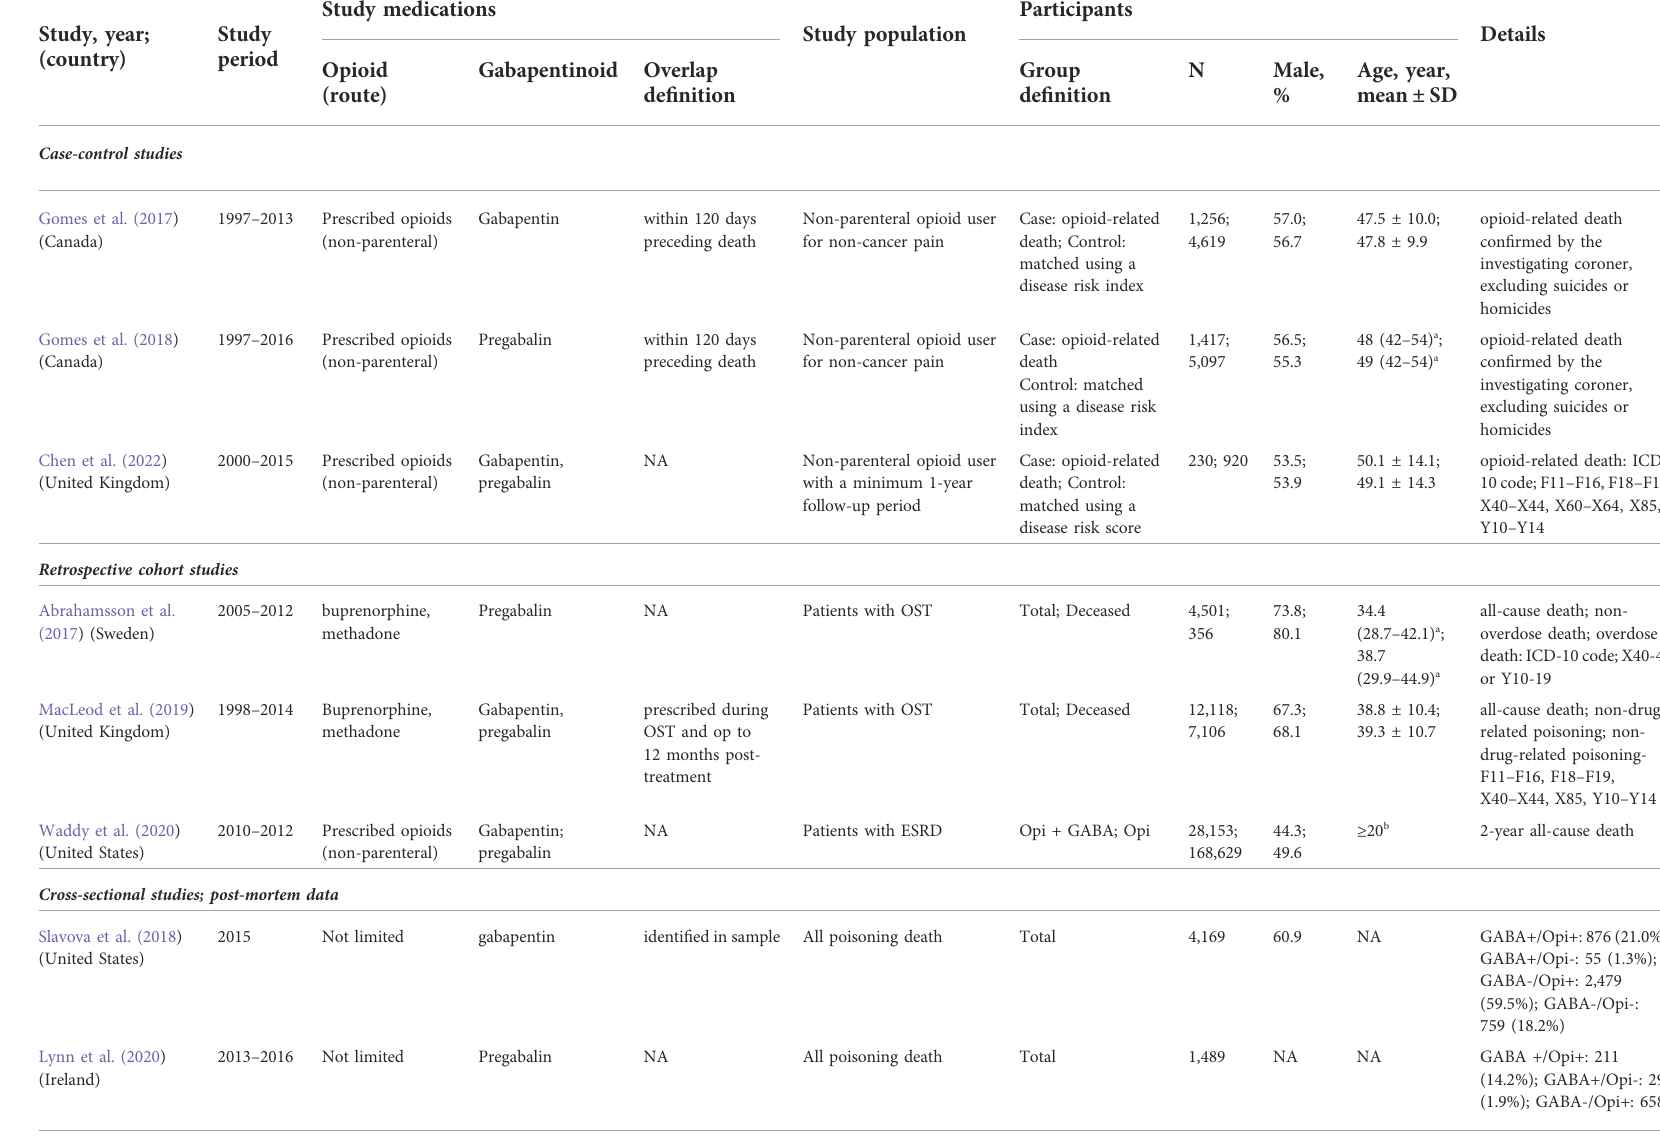
TABLE 2 Characteristics of studies reporting mortality risk.